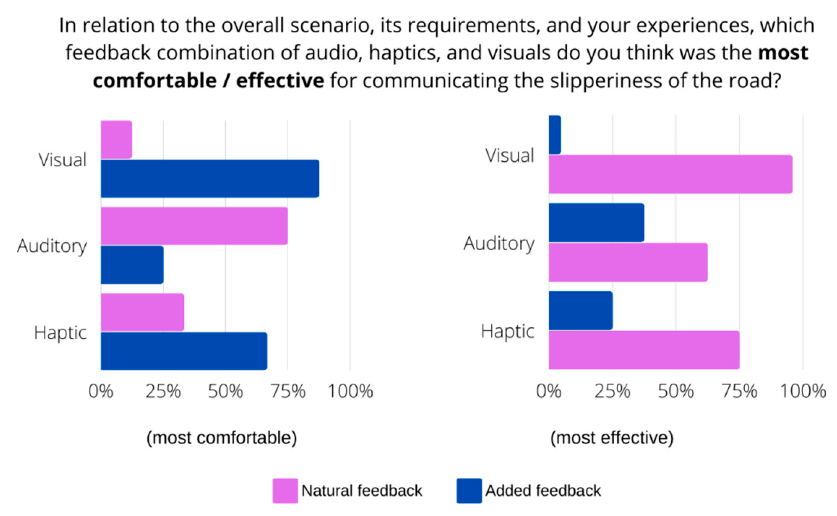
Figure 5. Subjective preferences of natural and added feedback by modalities.